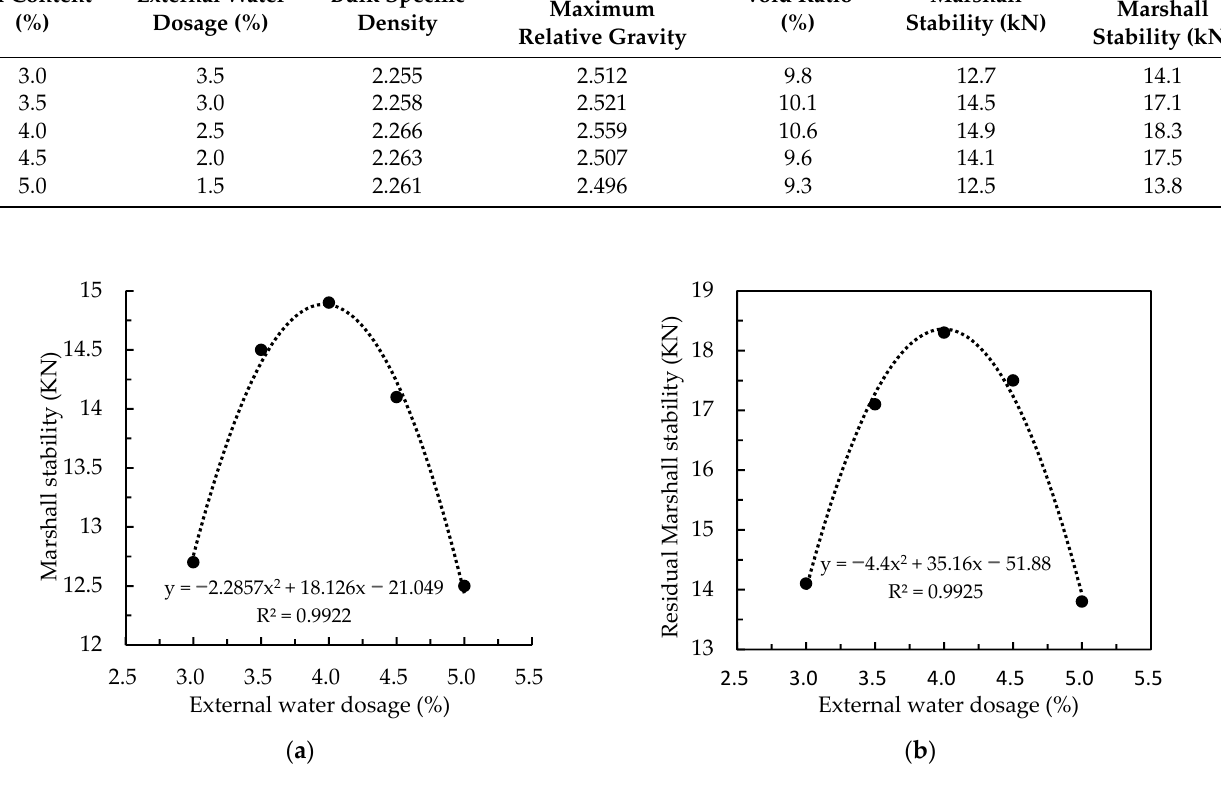
Figure 3. Relationships between external water dosage and the Marshall stability ( a ) and residual Marshall stability ( b ).